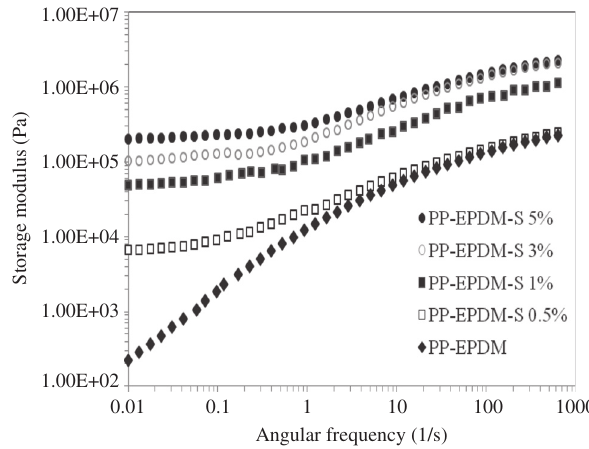
Figure 3 Storage modulus vs. angular frequency of PP/EPDM and its nanocomposites reinforced with SWNT.